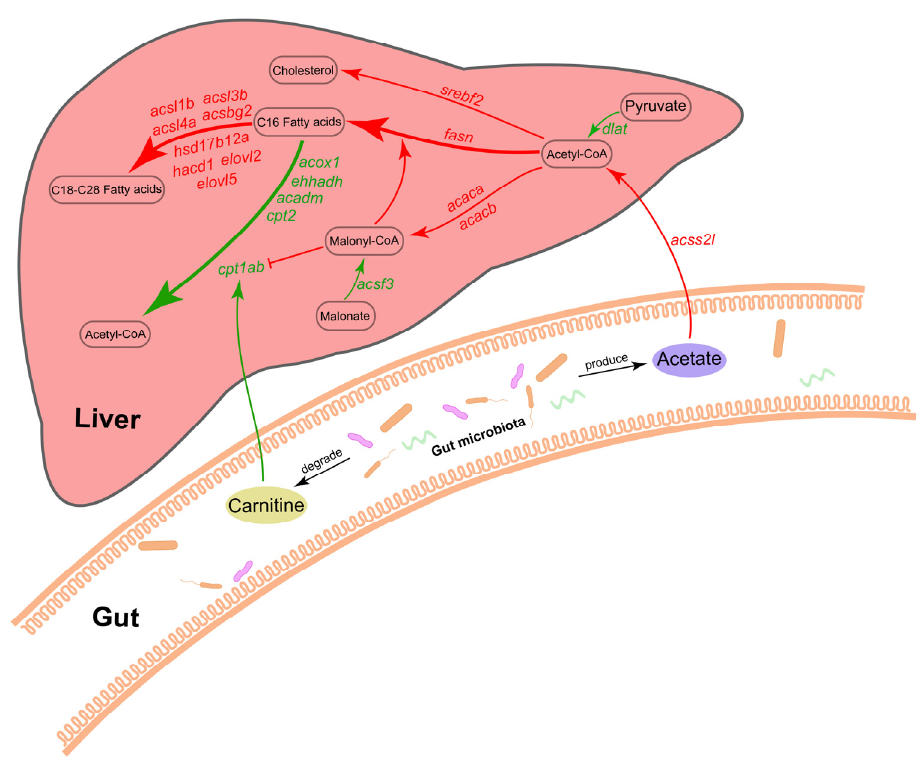
Figure 7. Potential mechanisms for regulation of liver fatty acid metabolism by gut microbiota. Red represents upregulation, and green represents downregulation.